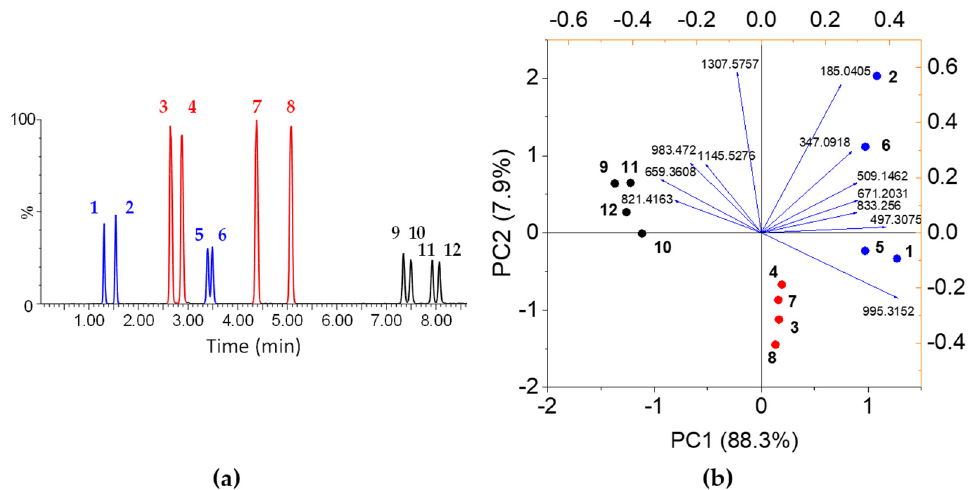
Figure 1. ( a ) Extracted ion chromatogram (EIC) of [Lip β CD + Na] + ( m / z 1469.626) obtained fromUHPLC-HRMS separation of the 12 Lip β CD isomers of DS = 1. It should be noted the 12 isomers are labelled by their elution order: 1 , 2 , 3 …. 12 ( b ) PCA based on MS/MS fragment ions common to all isomers and built with their intensity.